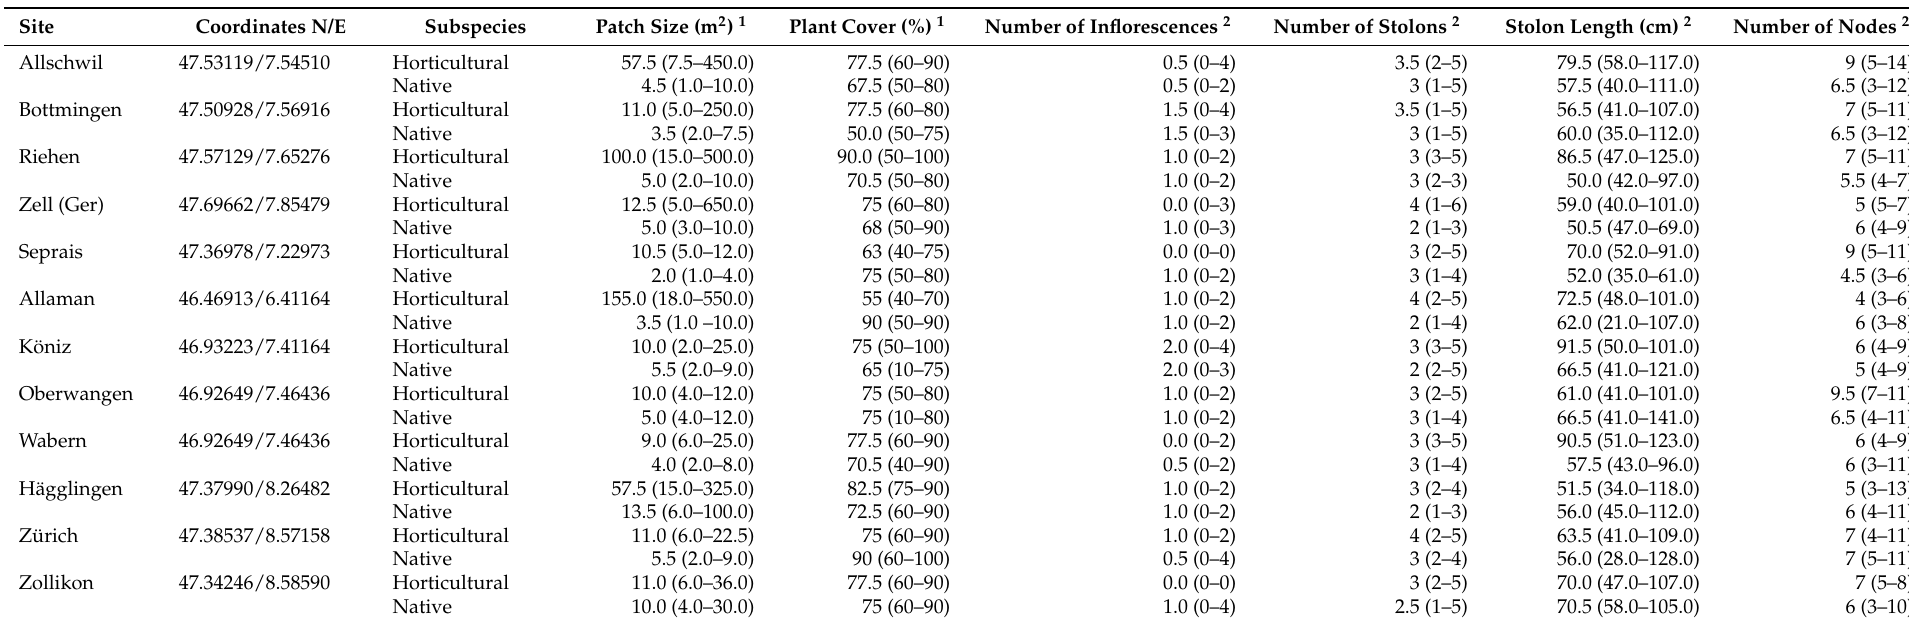
Table 1. Plant traits of horticultural Lamium galeobdolon subsp. argentatum and native Lamium galeobdolon subsp. galeobdolon in 12